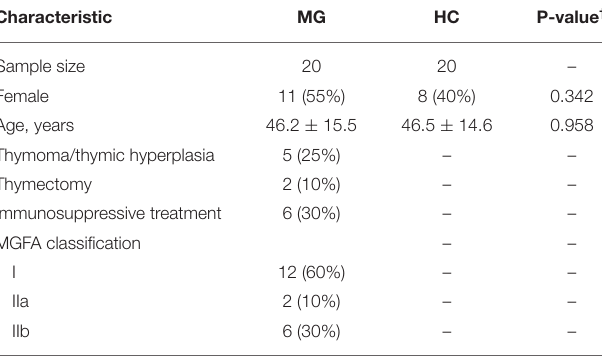
TABLE 1 | Clinical characteristics of the study